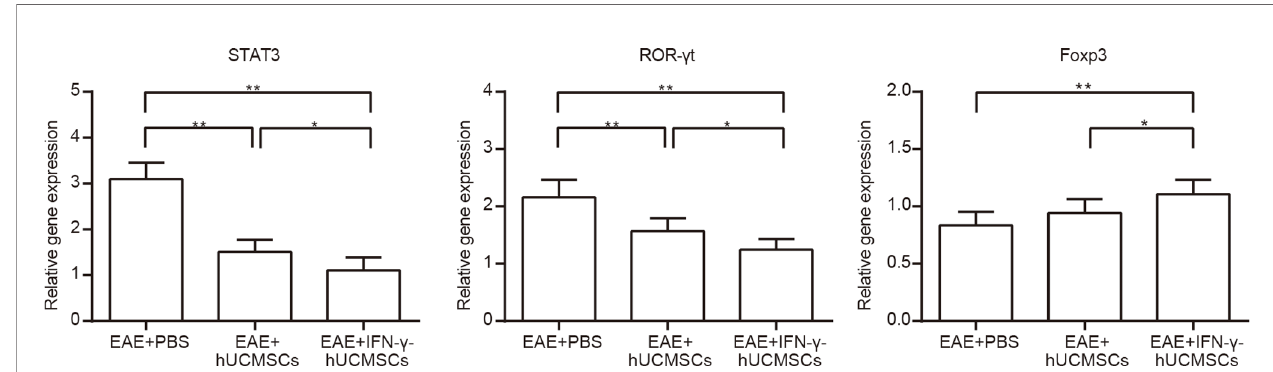
FIGURE 3 | Messenger RNA (mRNA) expressions of Foxp3 , ROR- g t , and STAT3 in the cell transplantation groups. The expressions of STAT3 and ROR- g t were signi fi cantly downregulated and that of Foxp3 was upregulated in the cell transplantation groups, especially in the IFN- g -primed human umbilical cord mesenchymal stem cells (IFN- g -hUCMSCs) transplantation group. * p < 0.05, ** p < 0.01, ( n = 8